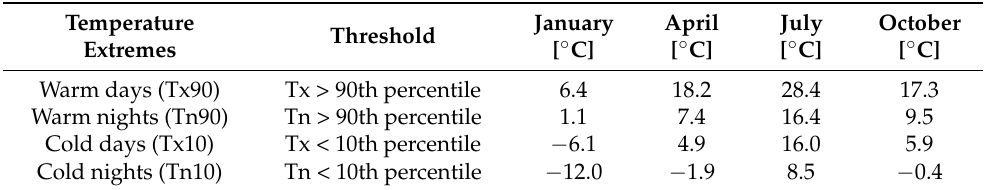
Table 2. Definition of temperature extremes. Mean January, April, July, and October temperature thresholds calculated as the mean for 11